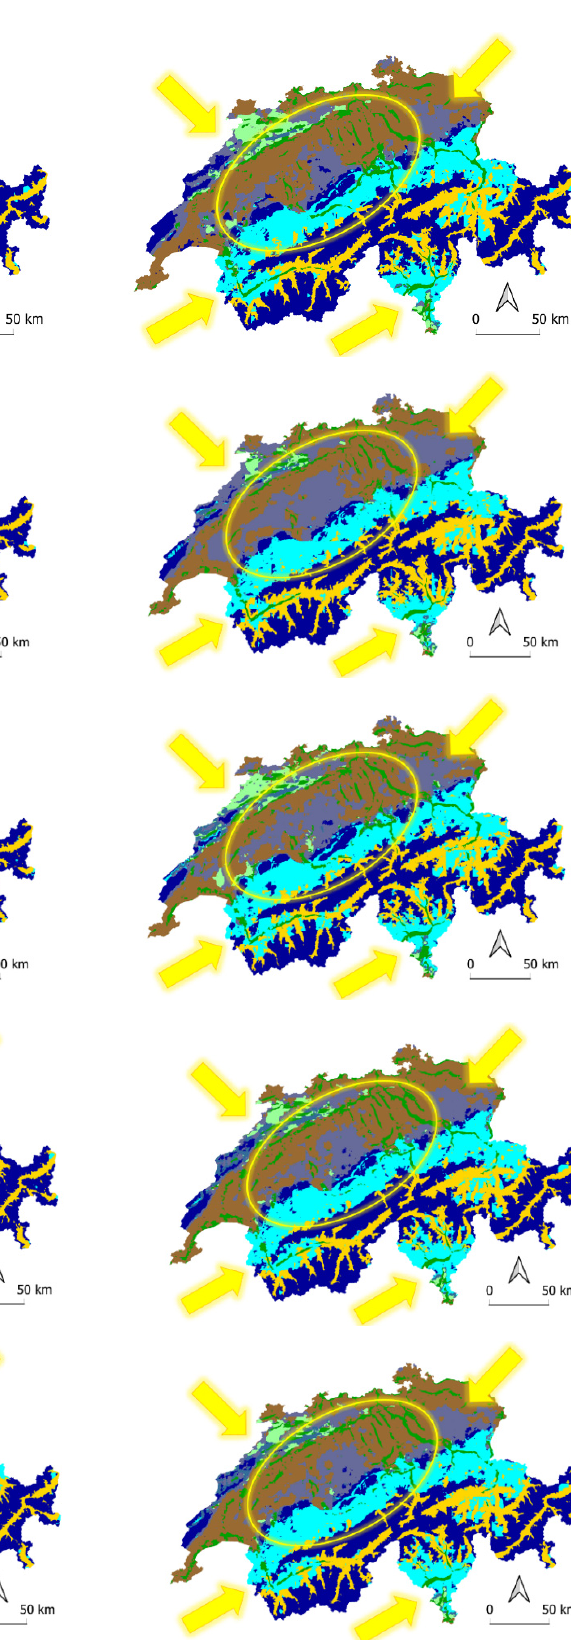
Figure 5. Predictions of each of the 10 training models with differences marked in yellow.